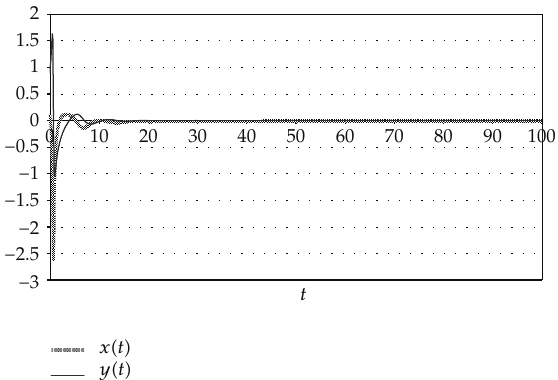
Figure 1: x (cid:2) 0 (cid:3) (cid:6) 0.1, y (cid:2) 0 (cid:3) (cid:6) 0.9, a (cid:6) 0.1, b (cid:6) 0.9, alpha (cid:6) 0.8.